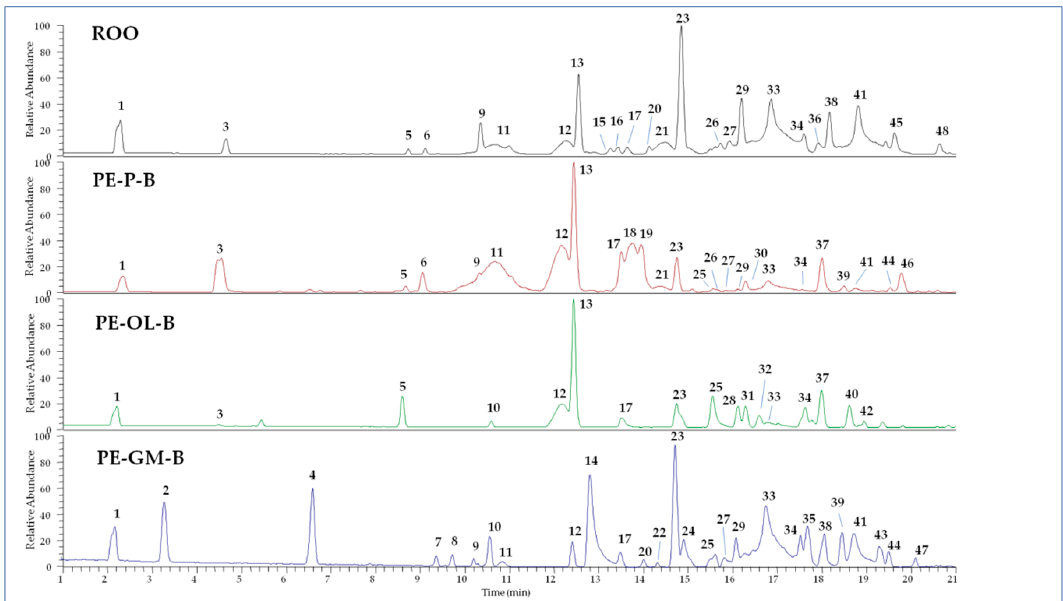
Figure 2. UHPLC-HR-ESI-MS profiles of extracts from refined olive oil (ROO) control, phenol-enriched ROO from olive pomace (PE-P-B), olive leaves (PE-OL-B), and grape marc (PE-GM-B). Peak data are listed in Table S1.